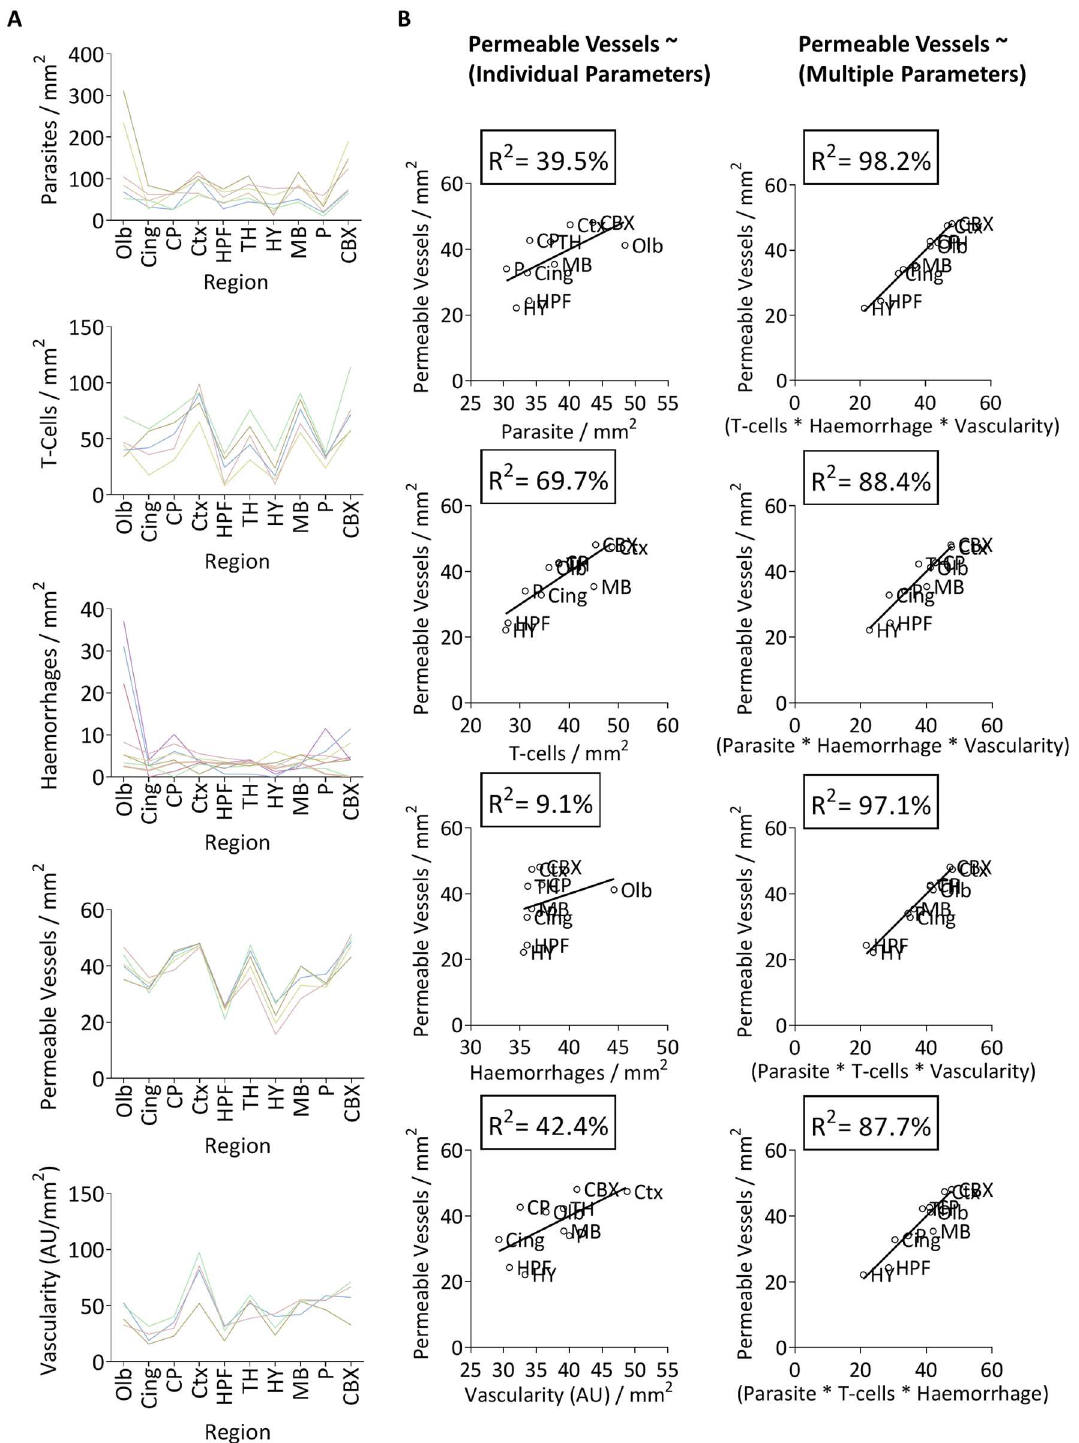
Fig 10. The deterministic and multifactorial nature of ECM. (A) The magnitude of the various pathogenic features within all ten brain regions, plotted separately for individualmice with late stage ECM (n = 4–8). (B) Generalised linear model analysesassessingthe contribution of the pathogenic features, in isolationand in combination, in promoting vascular leakagewithin the brain during late-stage ECM. Each data point representsthe mean of the group for each regionduring late-stage ECM (N =